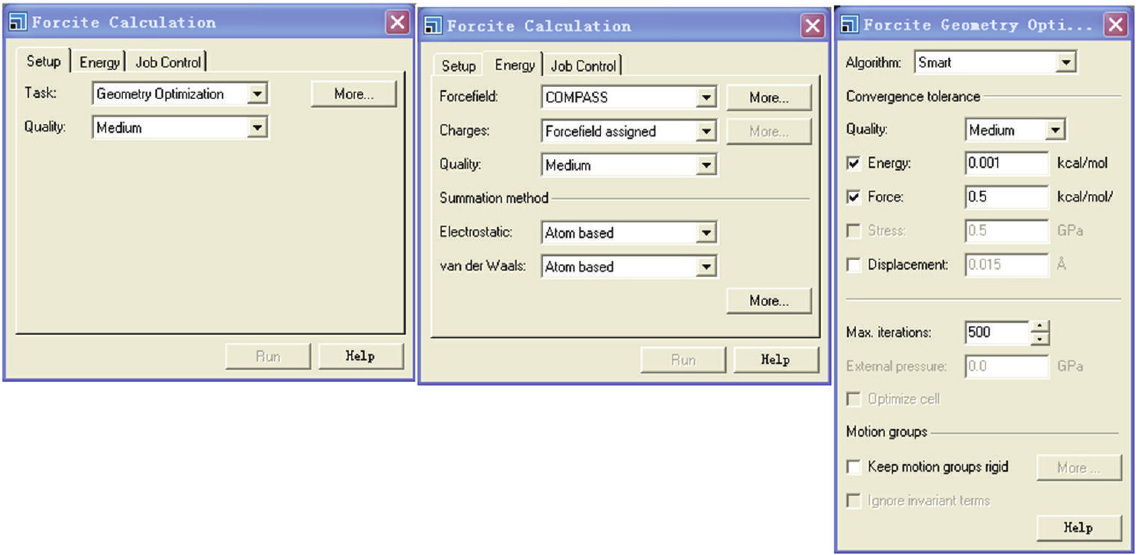
Figure 1: The details of the simulation parameters for structure optimizations of NZVI particle and water molecule.